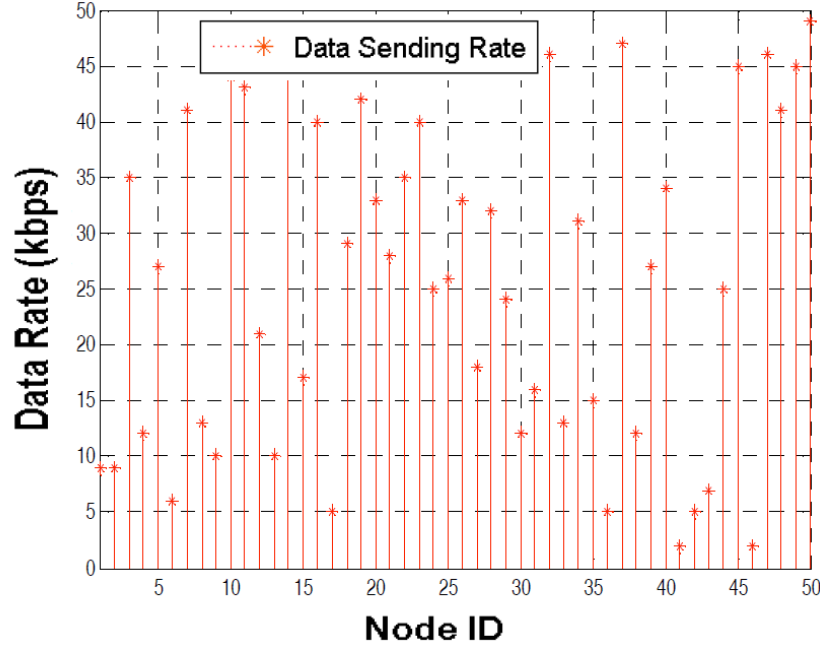
Figure 8. Data sending rate of the network. Future Internet 2017 , 9 , 54